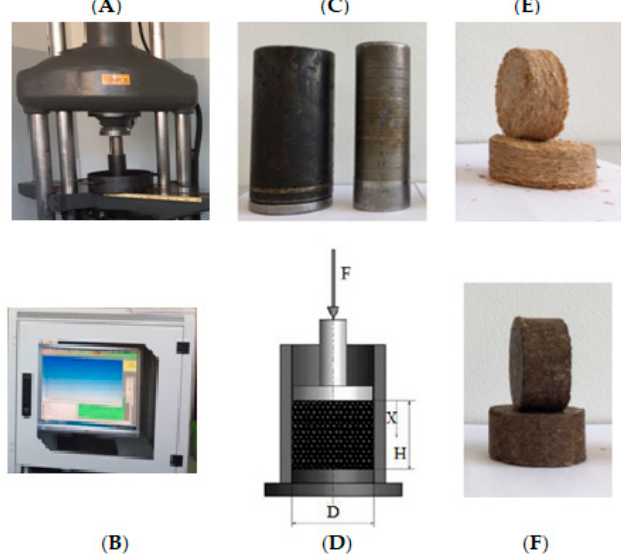
Figure 3. ( A ) Compression test process. ( B ) A computer monitor for data display. ( C ) Pressing